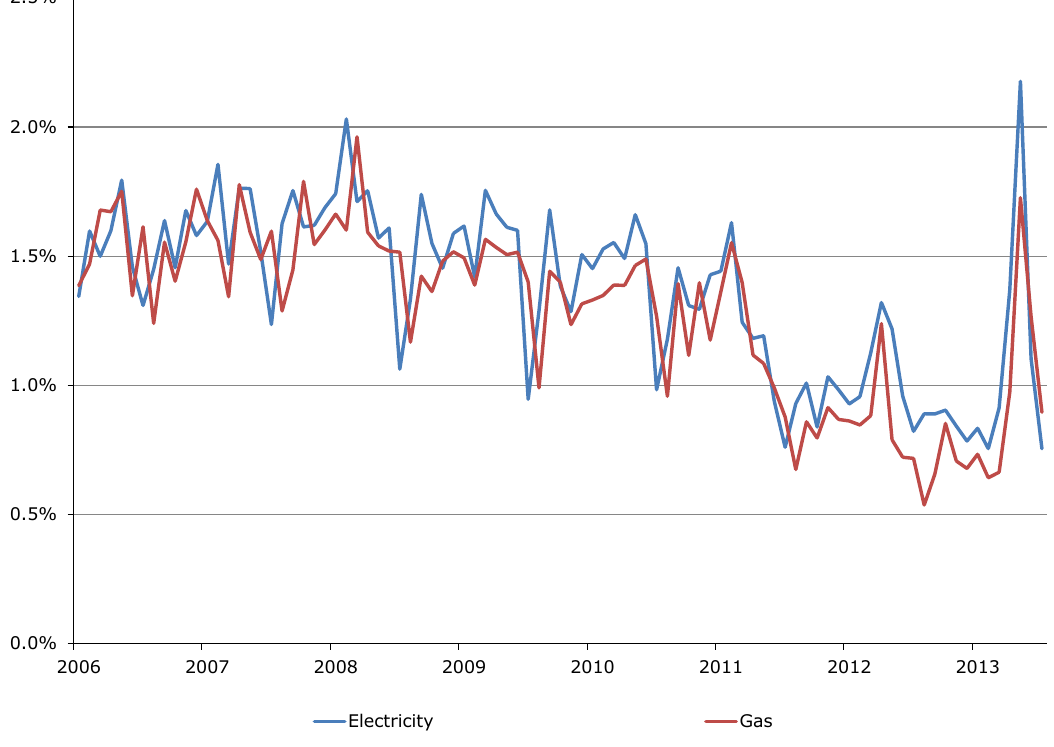
Figure 9: Monthly switching